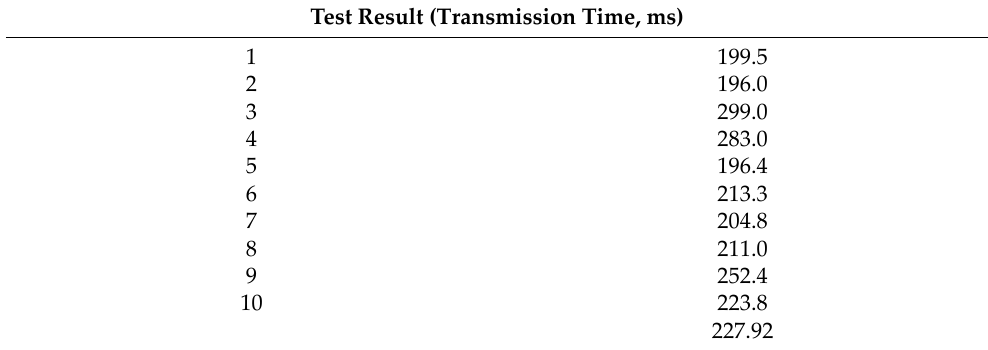
Table 12. Test results during ten times of repetition.